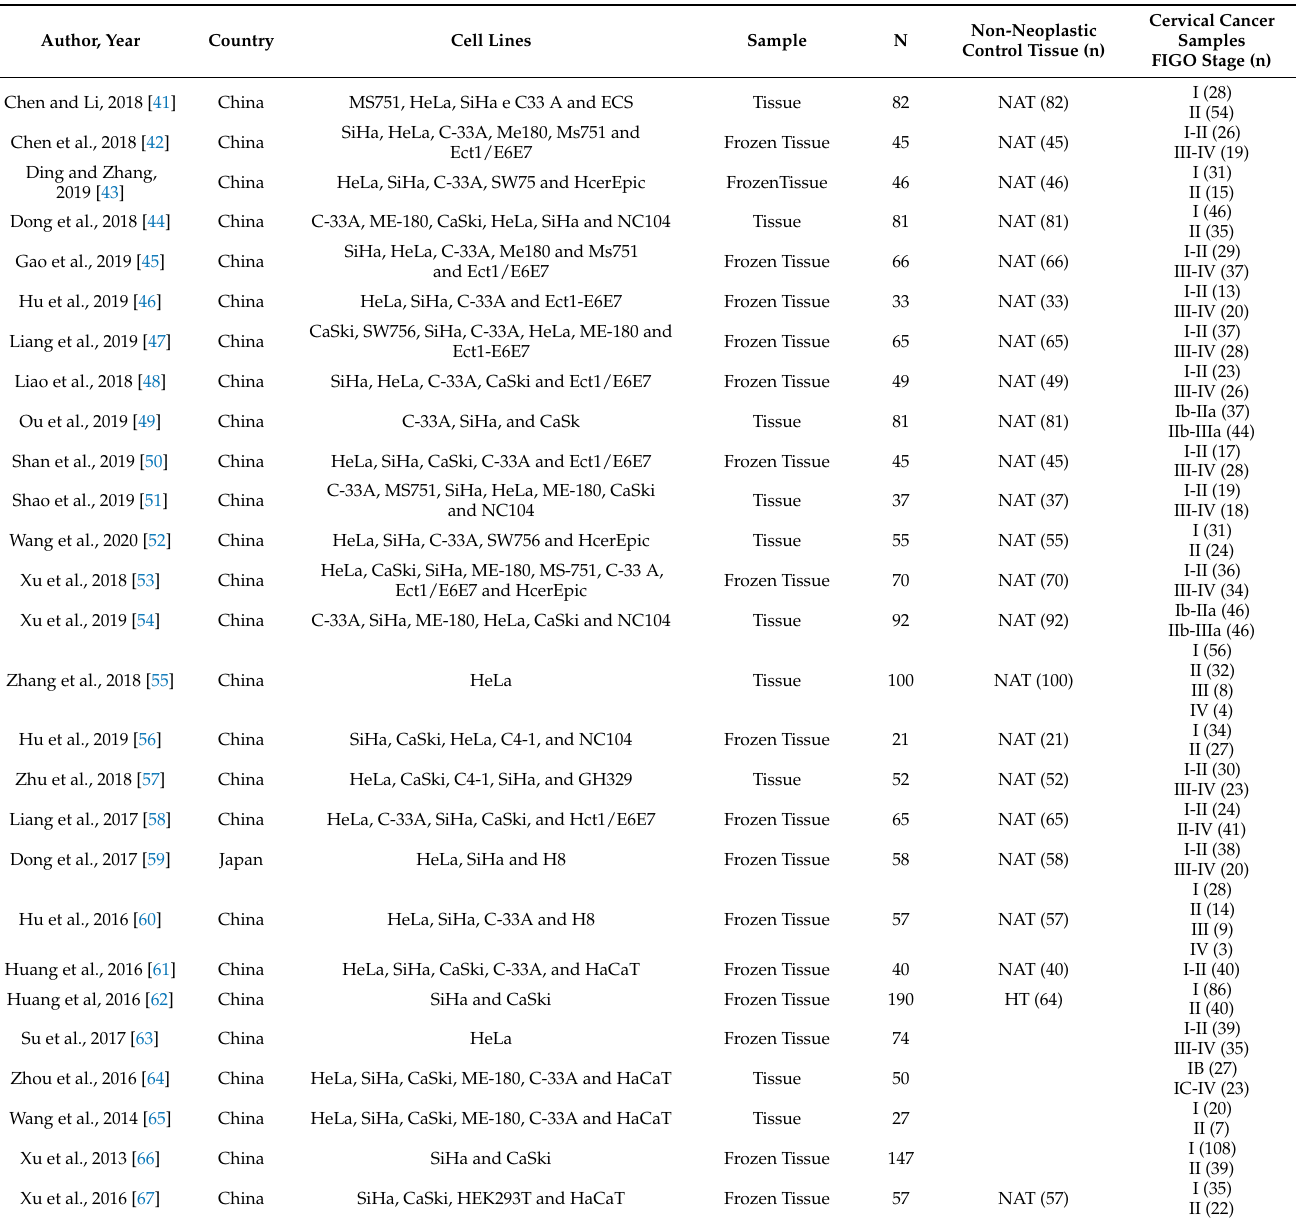
Table 2. Characteristics of studies included in the current